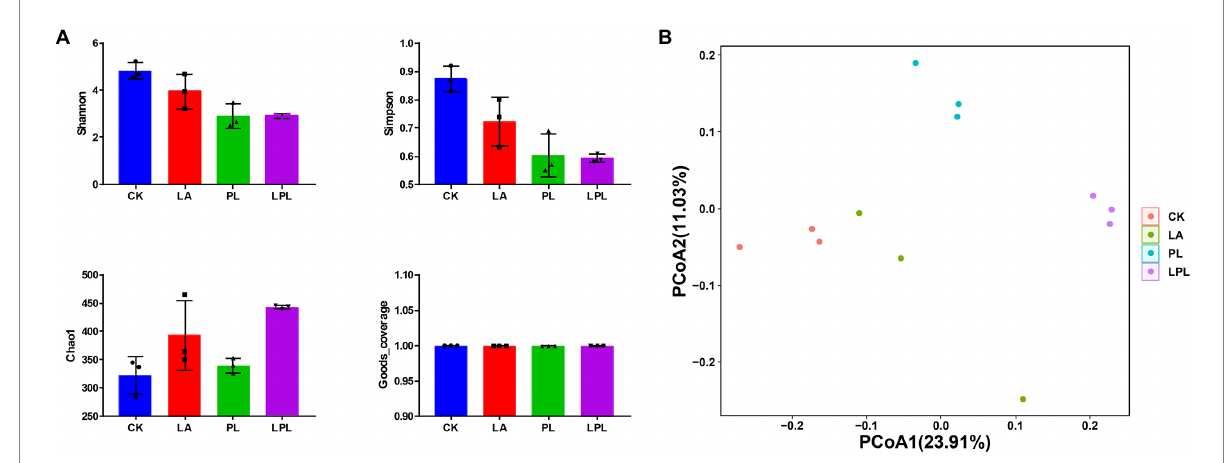
FIGURE 2 Bacterial community diversities of alfalfa silage treated with or without additives. (A) Alpha-diversity of bacterial community (Shannon, Simpson, Chao1, and Goods_coverage). (B) Principal coordinates analysis plots with unweighted Unifrac dissimilarity of bacterial community. ANOSIM value, R -squared: 0.75, p = 0.001. CK, no additives; LA, laccase; PL, Pediococcus pentosaceus ; LPL, laccase + Pediococcus pentosaceus